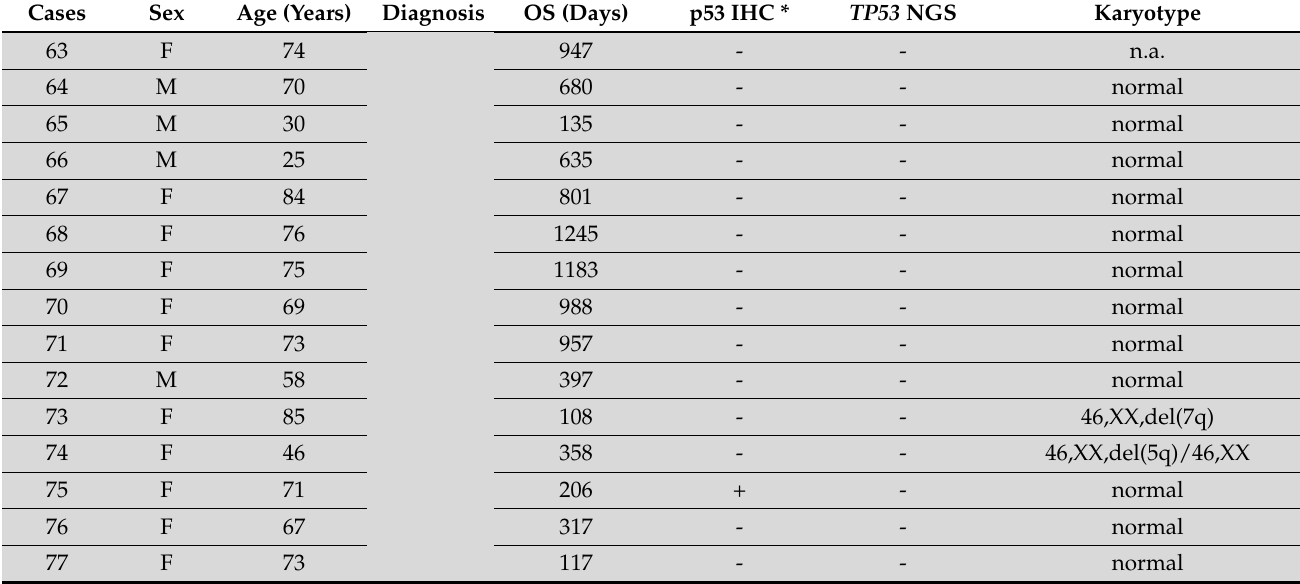
oligomerization domain (OD) (323–355 AA), and lysin-rich C-terminal tail (LR) (364–393 AA). “fs”: type of AA change is a frameshift, “X”: termination